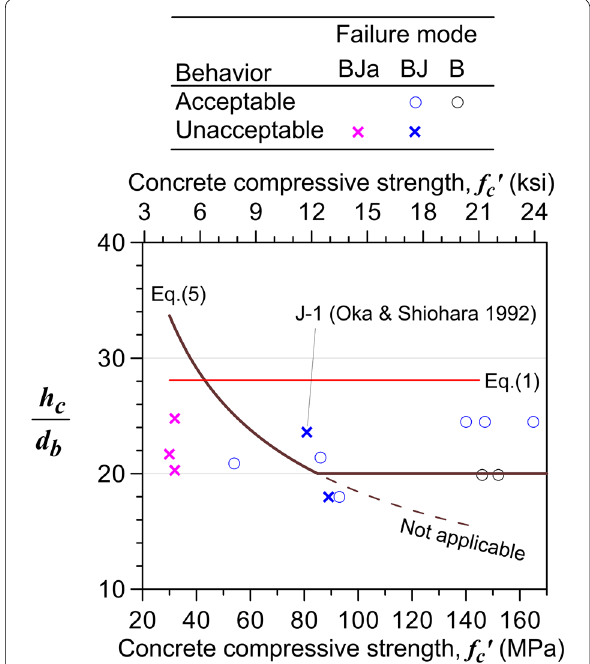
Fig. 7 Relations of the h c / d b ratio, measured concrete compressive strength, and evaluated hysteresis performance for joints with Grade 590 or 600 MPa beam bars.